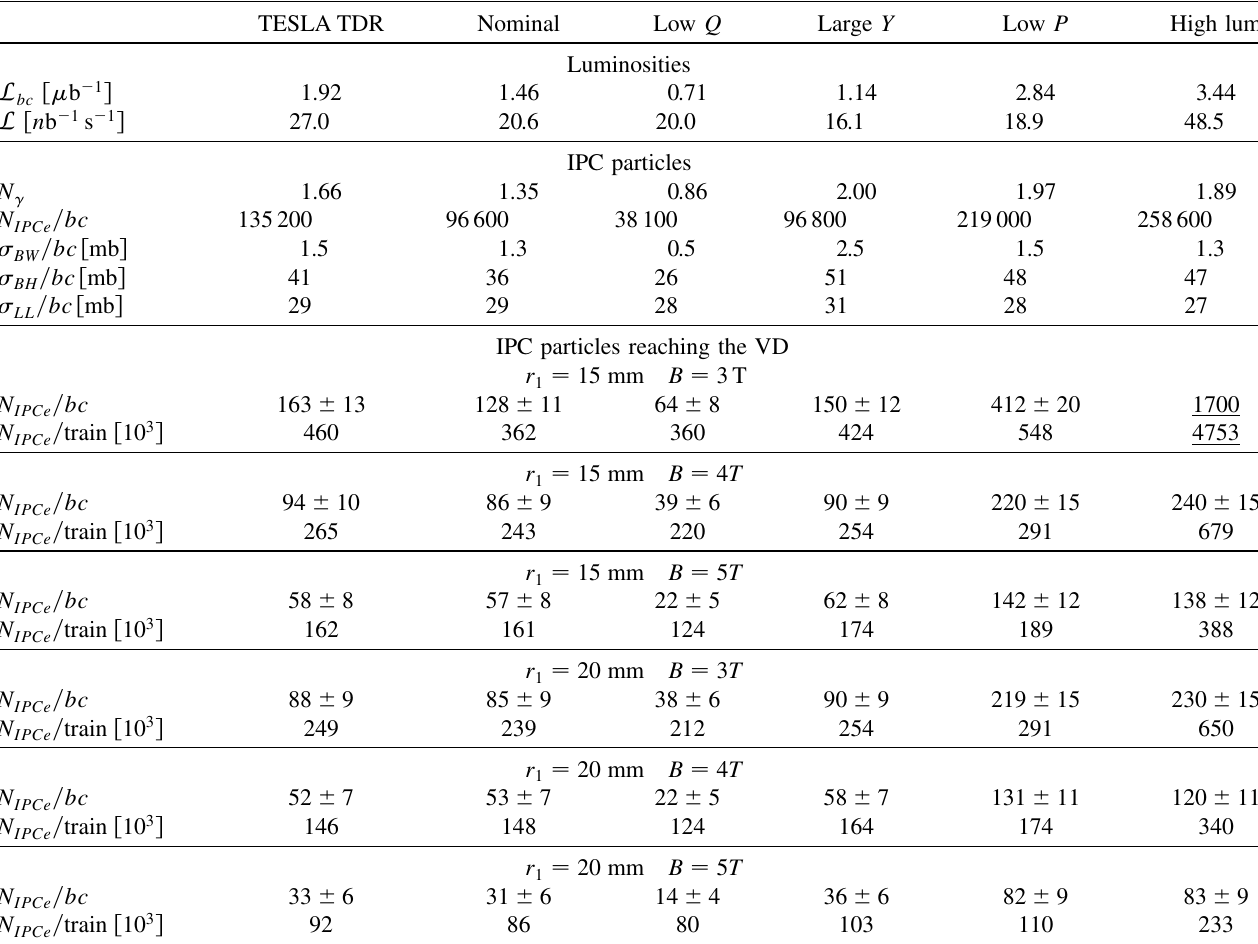
TABLE VII. GUINEA-PIG simulation results of background production for different ILC design optimizations. The TESLATDR case is shown for